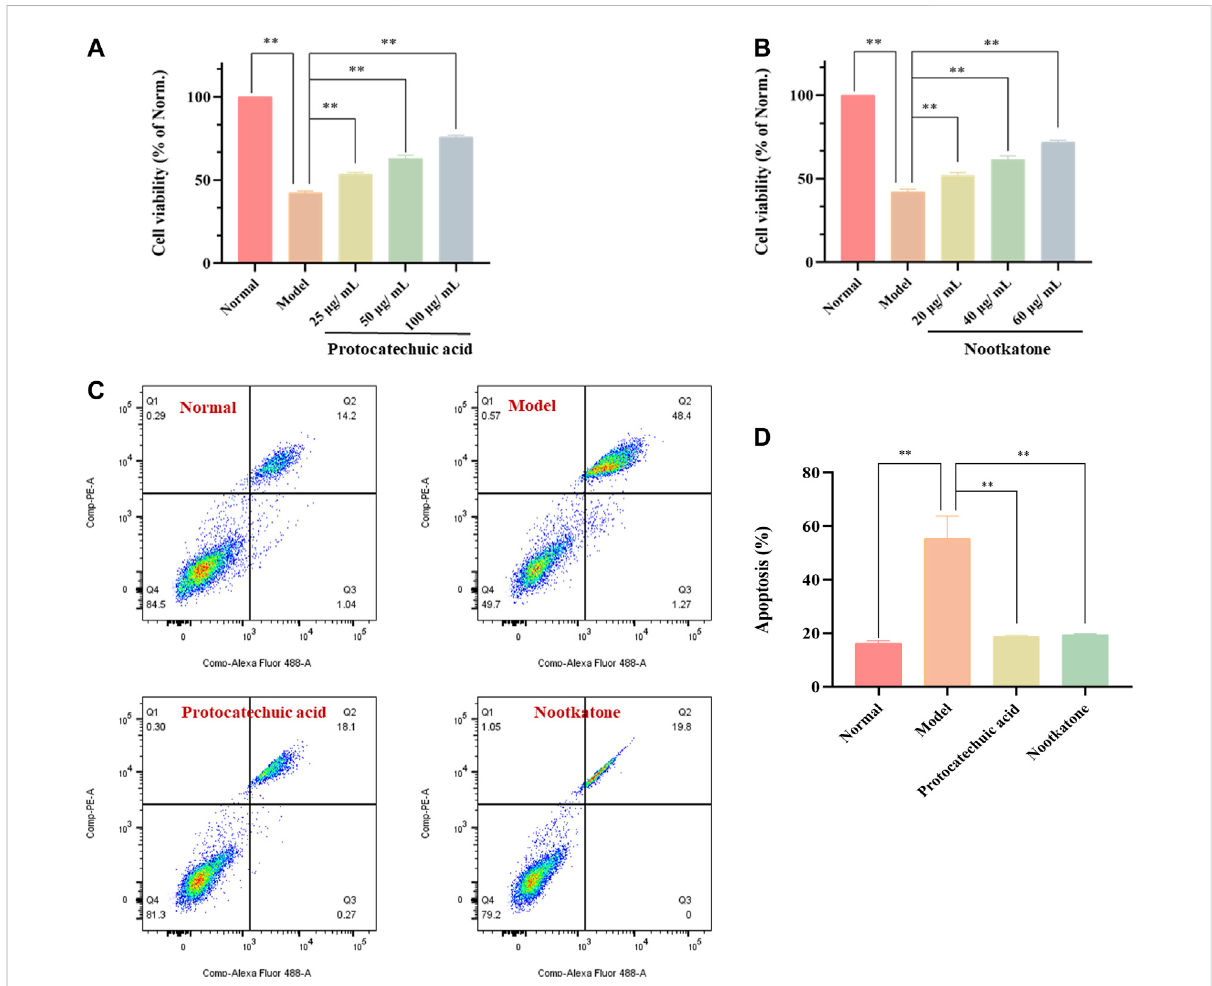
FIGURE 9 Effects of the main active components (protocatechuic acid and nootkatone) on cell viability and apoptosis in H 2 O 2 -stimulated PC12 cells (A) Effects of protocatechuic acid on cell viability of H 2 O 2 -stimulated PC12 cells under different concentration (25, 50 and 100 μ g/ml) (B) Effects